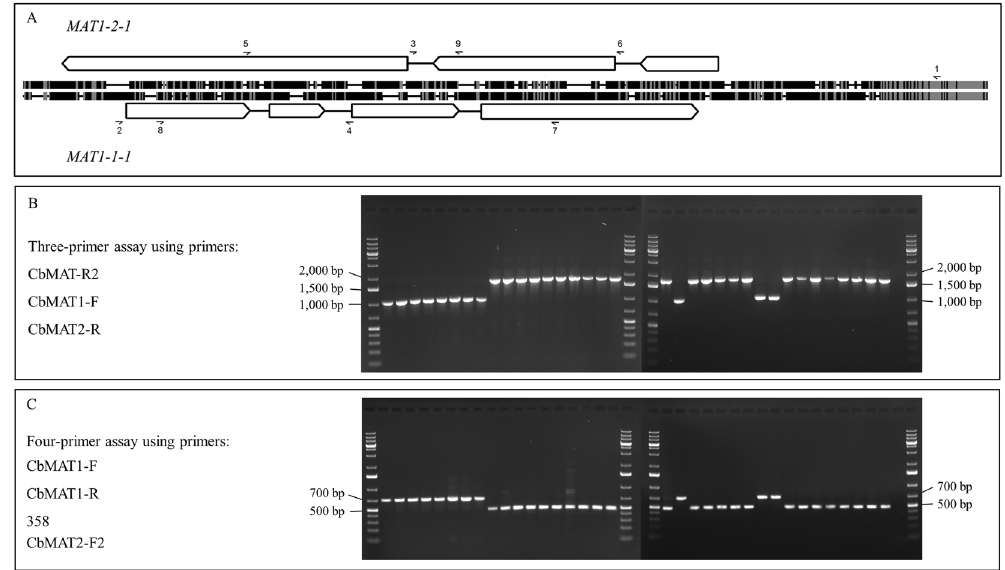
Figure 7. ( A ) Schematic alignment of the MAT1 idiomorphs in Cercospora beticola; MAT1-2-1 (top) and MAT1-1-1 (bottom), showing the position and orientation of the open reading frames with arrowed boxes, and position of introns with black lines. The position of the primers used for mating-type determination are shown with arrows bearing the primer number according to Table 5. The thick black and grey lines in the alignment represent differences and similarities, respectively. ( B ) Three-primer mating-type assay, resulting in PCR amplicons of ~1,700 and ~1,050 bp in MAT1-1 and MAT1-2 isolates, respectively. ( C ) Four-primer mating type assay, resulting in PCR amplicons of ~500 and ~700 bp in MAT1-1 and MAT1-2 isolates, respectively. The first and last line in each gel include 6 µ L of O’GeneRuler 1 kb Plus DNA Ladder (Thermo Scientific).